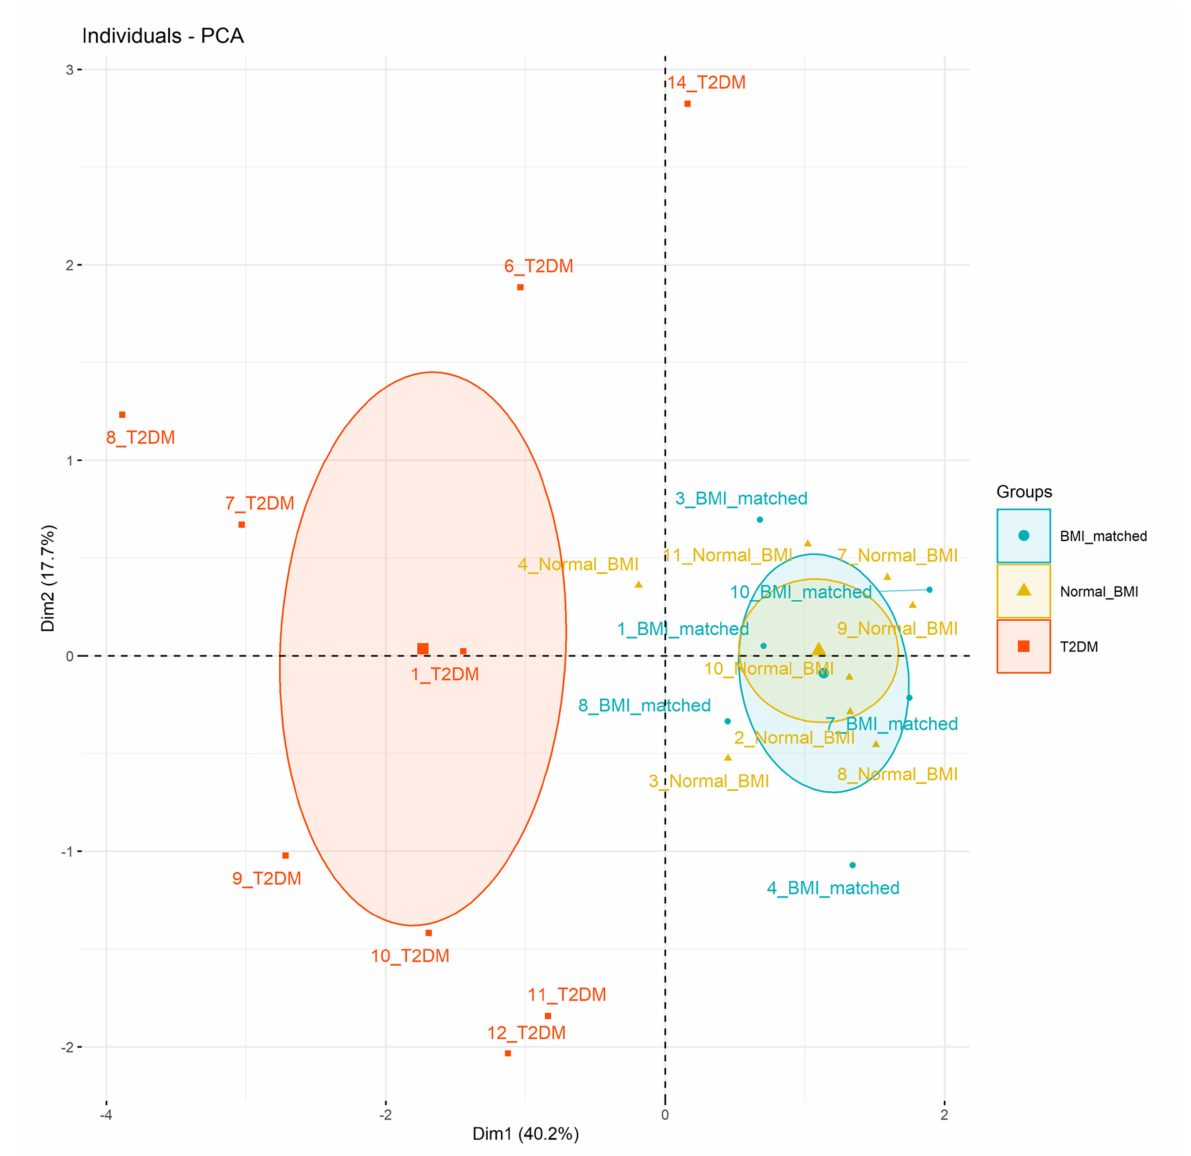
Figure 2. Principal component analysis. Data considered: principal component 1 ( x -axis, 40% variance) infant hypoglycaemia, (correlation 0.78), formula use in hospital (correlation 0.75), cit- rate concentration at 72 h (correlation 0.74), principal component 2 ( y -axis, 18% variance) protein concentration at 72 h (correlation 0.54), and lactose concentration at 72 h (correlation